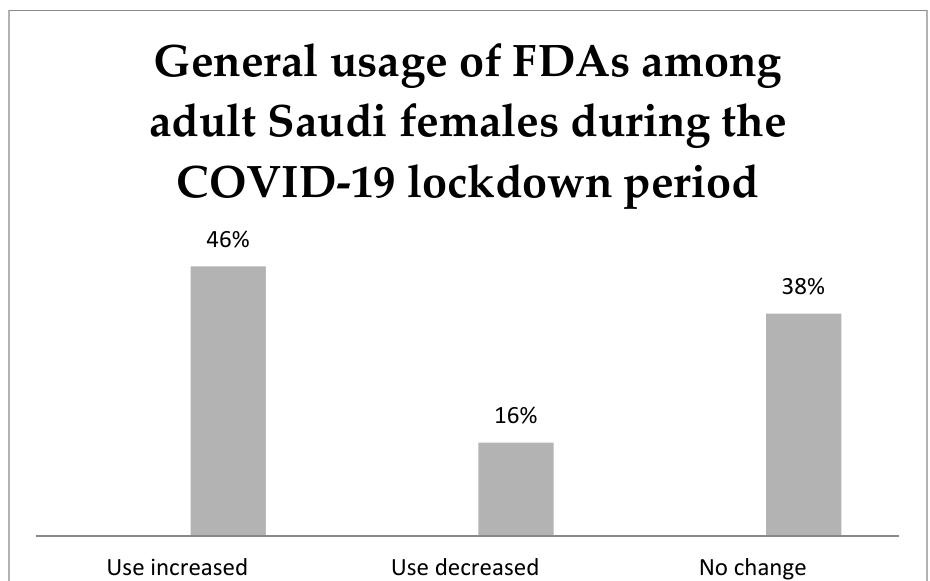
Figure 1. General usage of food delivery applications (FDAs) among adult Saudi females during COVID-19 lockdown period represented 46, 38 and 16% of increased, no change, and decreased their FDAs’ usage, respectively.